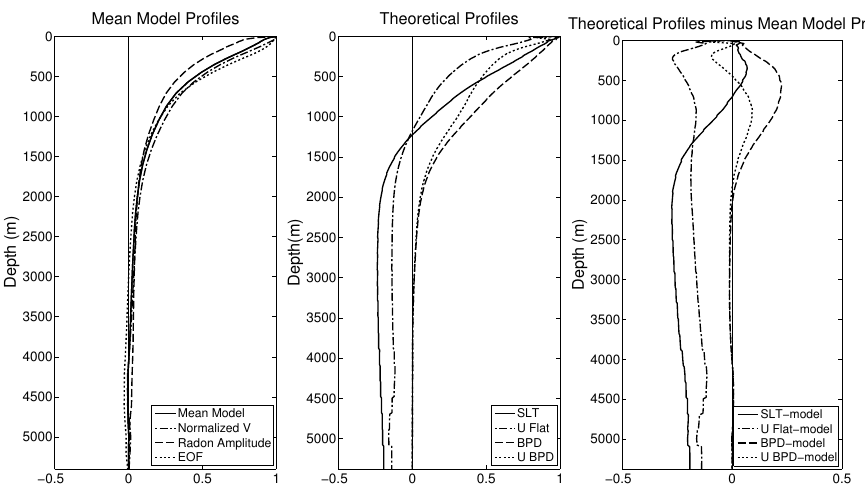
Fig. 7. Comparison of model and theoretical profiles. (a) Model profiles including a mean profile that is the mean of the profiles from the 3 methods, (b) theoretical profiles and (c) the theoretical profiles minus the mean model